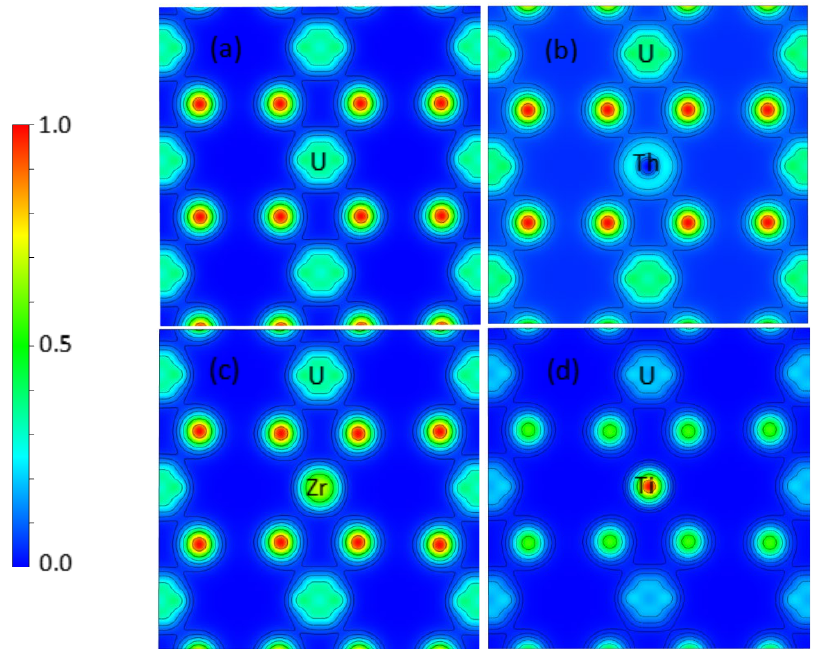
Figure 2. Electron charge density contour plots of UO 2 in the z = 0 plane, ( a ) U atom in perfect UO 2 , ( b ) Th-doped UO 2 , ( c ) Zr-doped UO 2 , and ( d ) Ti-doped UO 2